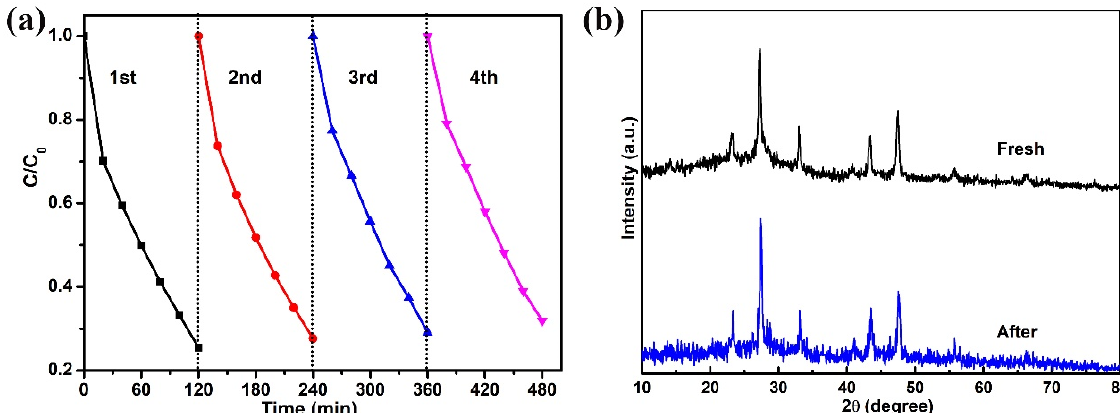
Figure 6. ( a ) Four cyclic experiments of TCH photodegradation over CISCN-2. ( b ) XRD patterns of CISCN-2 before and after cyclic experiments.